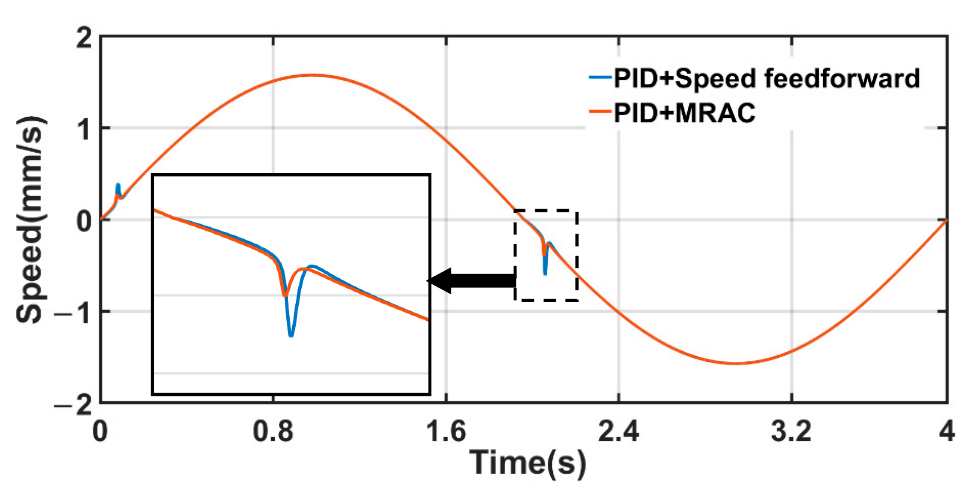
Figure 9. Comparison of the speed of two methods.